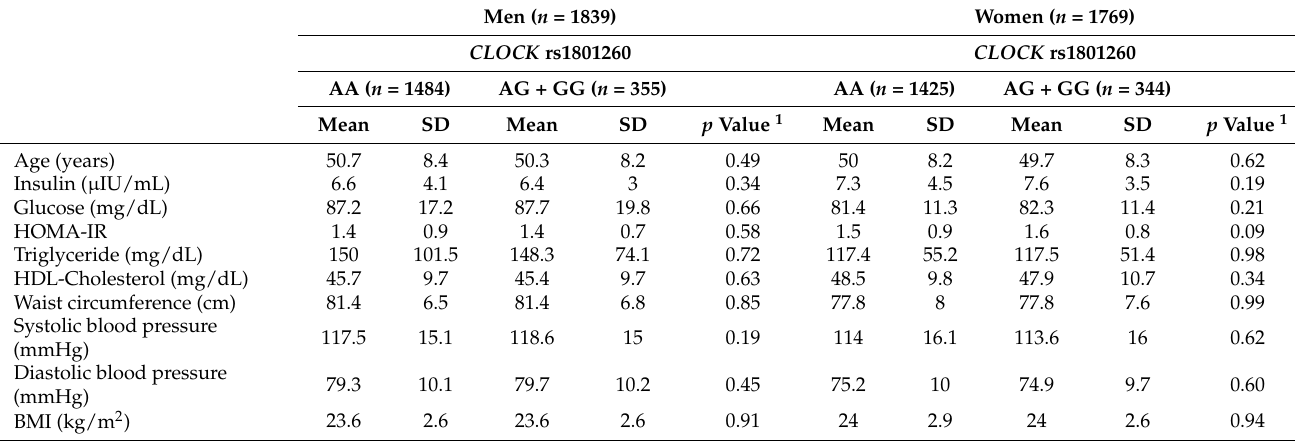
Table 2. Sociodemographic, clinical, and lifestyle characteristics of the study participants at baseline according to the CLOCK rs1801260